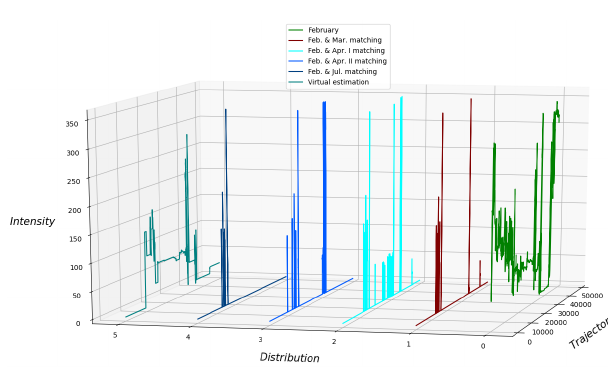
Figure 6. Unique light segments between Γ ≥ 0 . 7 SL=30 and ρ k